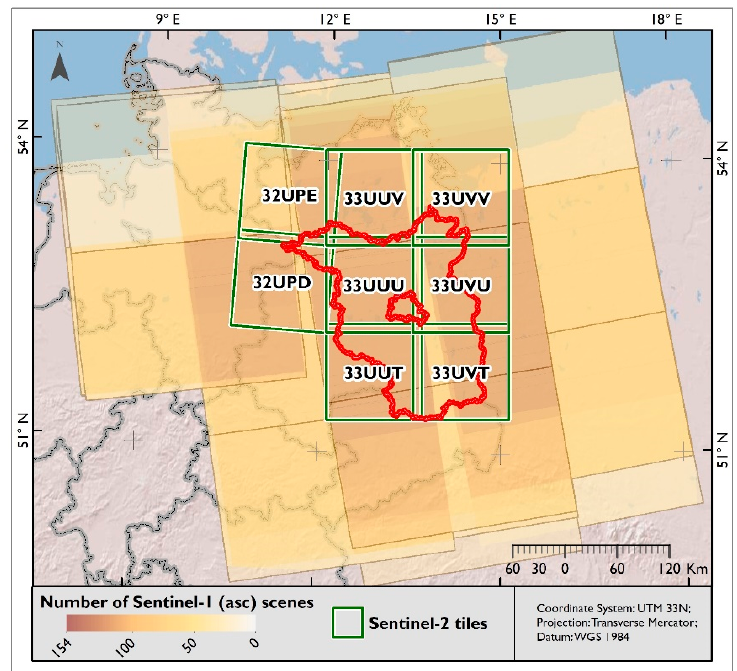
Figure 2. Overview of Sentinel-2 tiles covering Brandenburg and available Sentinel-1 SAR data (ascending mode) in the study region.